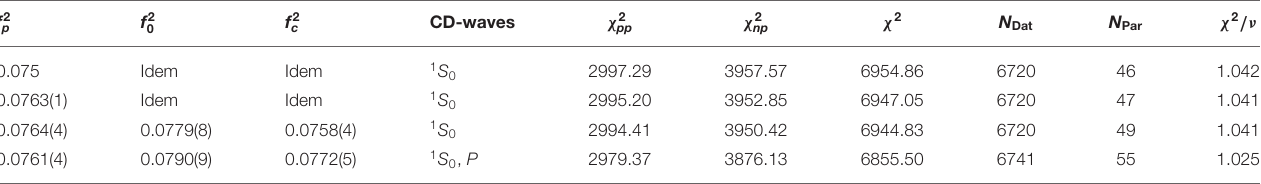
TABLE 6 | The pion-nucleon coupling constants f 2 p , f 2 0 , and f 2 c determined from different fits to the Granada-2013 database and their characteristics. f 2 p